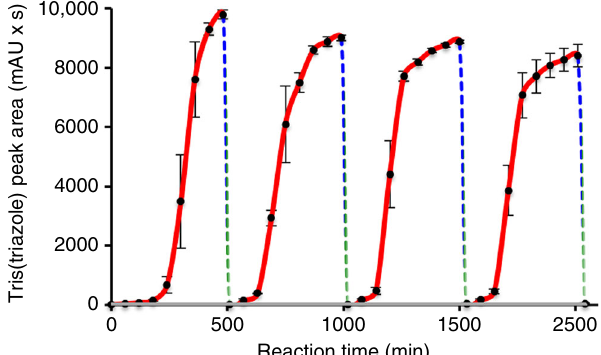
Fig. 4 Continual propagation of catalytic peptide nanospheres through serial transfers. Tris(triazole) peptide 5 formation ( red line ) with sequential serial transfers of nanospheres into fresh precursor solutions ( blue / green gradated line ) shows repeated and long-term oligotriazole peptide formation relative to controls lacking catalytic peptides ( gray line ). Tris(triazole) formation was monitored over time using combined liquid chromatography (LC), mass spectrometry (MS), and evaporative light-scattering detection (ELSD) measurements (raw LC data at 210 nm shown). Error bars represent standard deviations (SD) ( n =